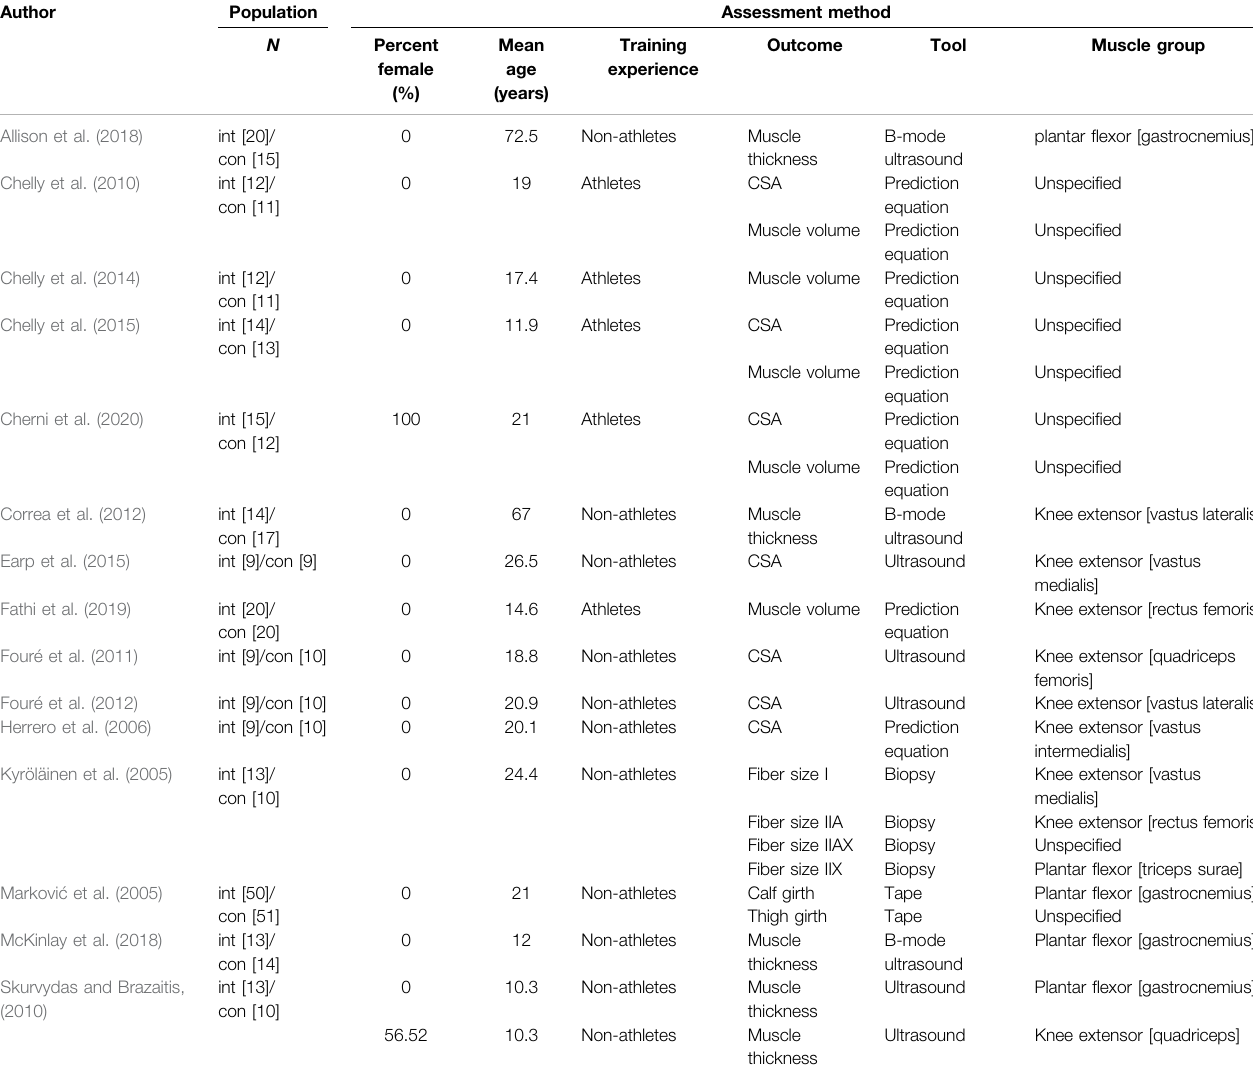
TABLE 1 | Characteristics of the population and assessment methods of included